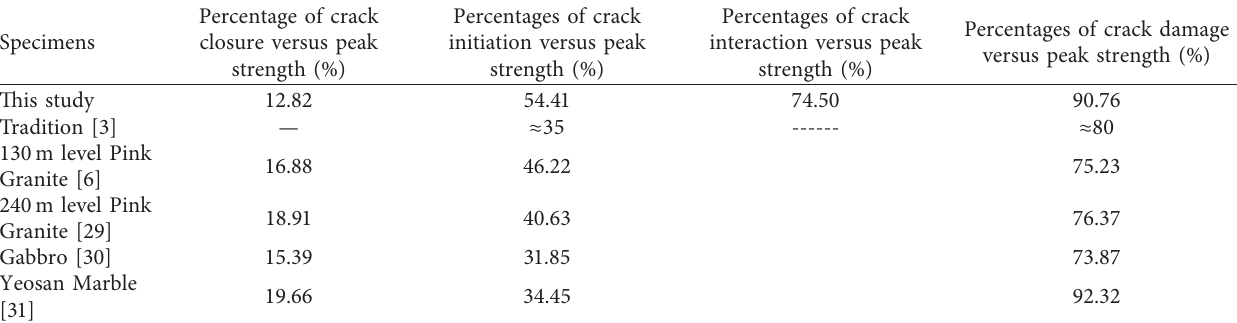
Table 2: Average values of percentages of various stress thresholds versus peak strength for rock